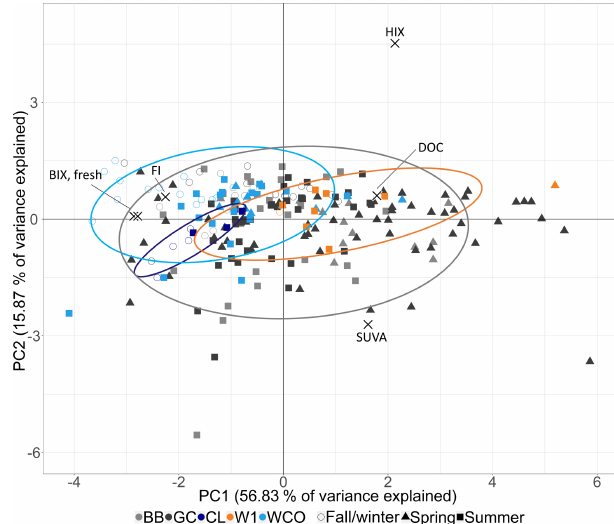
Figure 5. Biplot from PCA. PC1 is shown on the x axis, and PC2 is shown along the y axis. X indicates the point of the loadings with the applicable index written nearby. Samples are grouped by season: triangles represent spring (15 April–15 June), squares indi- cate summer (16 June–15 August) and circles represent fall/winter (16 August–14 April). Samples are also grouped by landscape type: bright blue represents mesoscale outlet (WCO), dark blue repre- sents lake (CL), orange represents Wetland 1 (W1) and grey repre- sents headwaters (light grey – BB and dark grey –